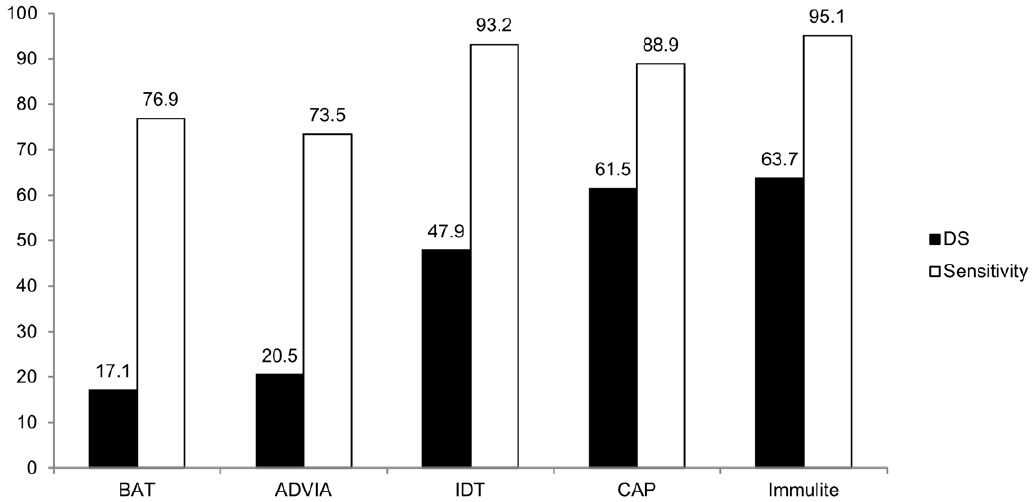
Figure 1. Frequency of double sensitization. The rate of DS in 117 consecutive patients differed significantly (p , 0.0001) and ranged from 17.1% with the BAT to 63.7% with the Immulite.